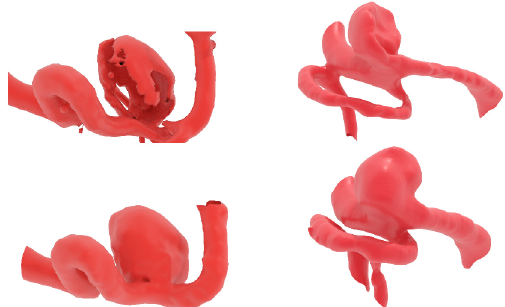
Above: complete 3D surface models of aneurysms are difficult to reconstructed automatically. Below: corresponding models manually created by